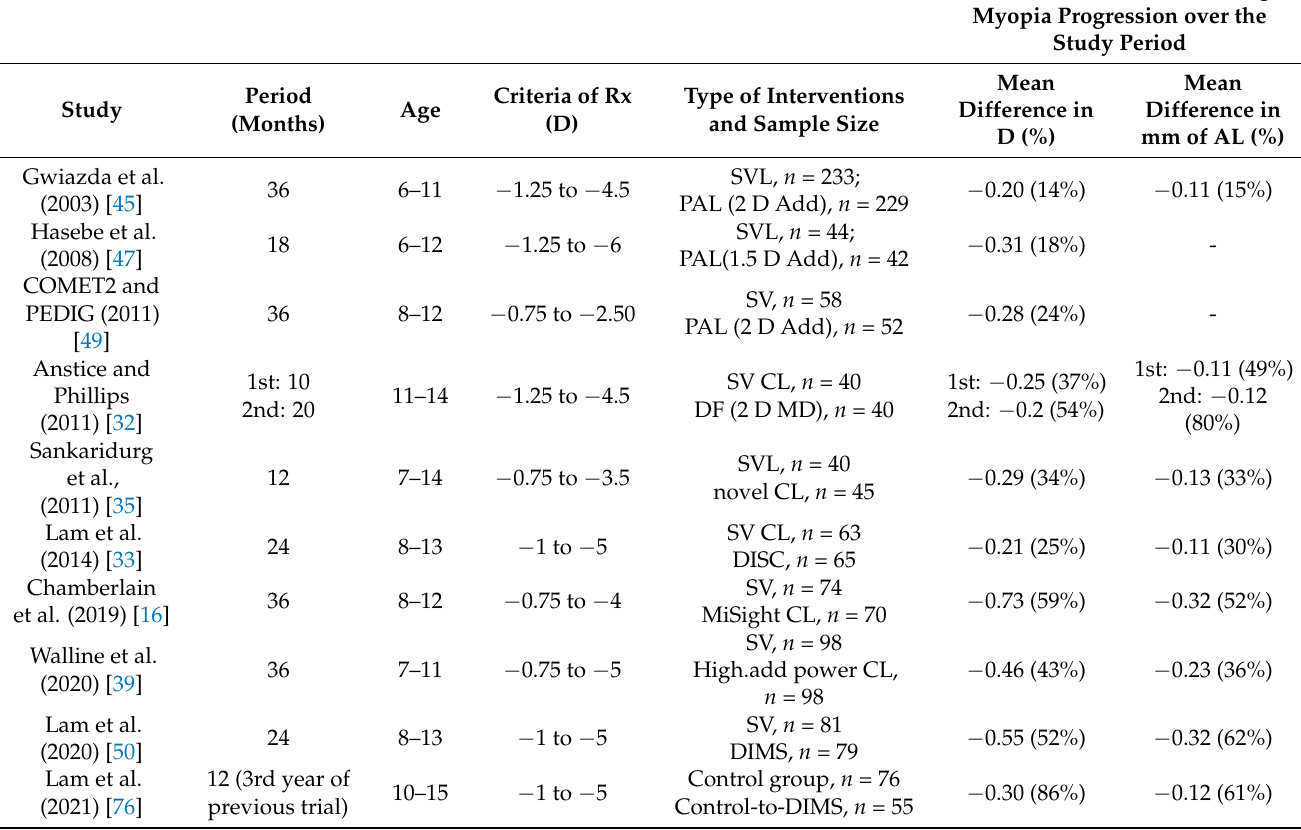
Table 1. Clinical studies on myopia progression management. BF, bifocal spectacle lens; COMET2 and PEDIG, Correction of Myopia Evaluation Trial 2 Study Group and the Pediatric Eye Disease Investigator Group; DF, dual-focus contact lens; DISC, Defocus Incorporated Soft Contact; MD, myopic defocus; PAL, progressive addition lens; SV CL, single vision contact lens; SVL, single vision spectacle lens; DIMS, Defocus Incorporated Multiple